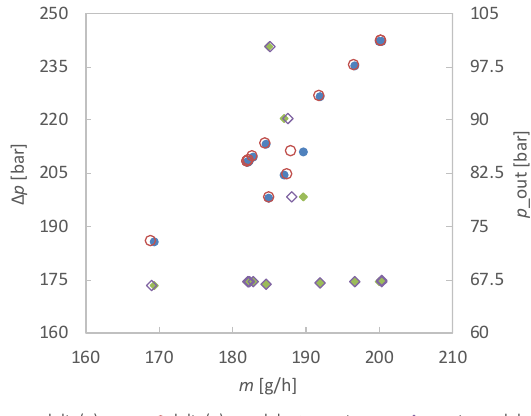
Fig. 8. CO 2 mass flow rate through isothermal capillary tube CAP 4 ( d = 0.1165 mm, L = 4.0 m) versus pressure drop over the capillary tube and outlet pressure after the capillary tube. Experimental data versus model.